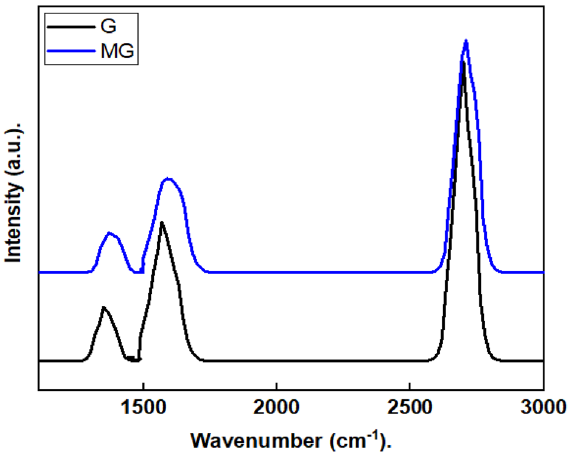
Figure 1. Raman spectra of the graphene, G, and modified graphene, MG.